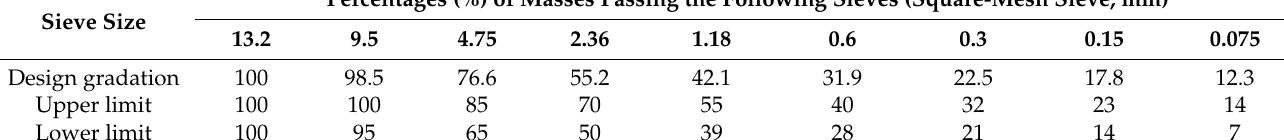
Table 7. Gradation of the hot-mix epoxy asphalt mixture.